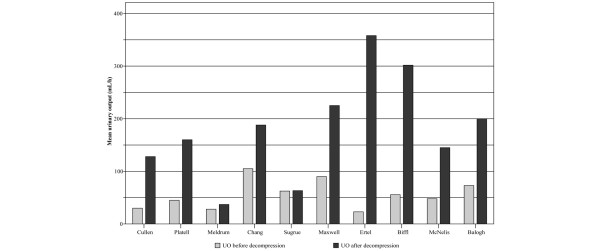
Effect of decompressive laparotomy on urinary output in 10 studies reporting urinary output (UO) before and after decompressive laparotomy. Data are from individual papers in this study; Cullen and colleagues [25], Platell and colleagues [26], Meldrum and colleagues [17], Chang and colleagues [28], Sugrue and colleagues [18], Maxwell and colleagues [29], Ertel and colleagues [2], Biffl and colleagues [32], McNelis and colleagues [33], Balogh and colleagues [35].